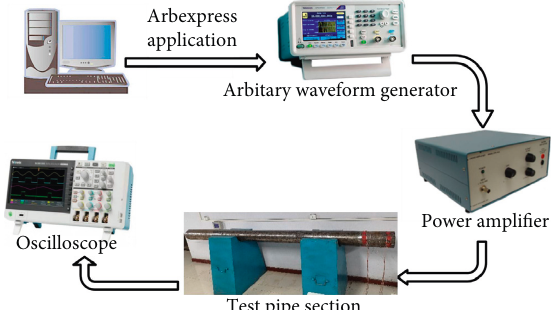
Figure 30: Time domain map of the ultrasonic guided wave in the nondestructive